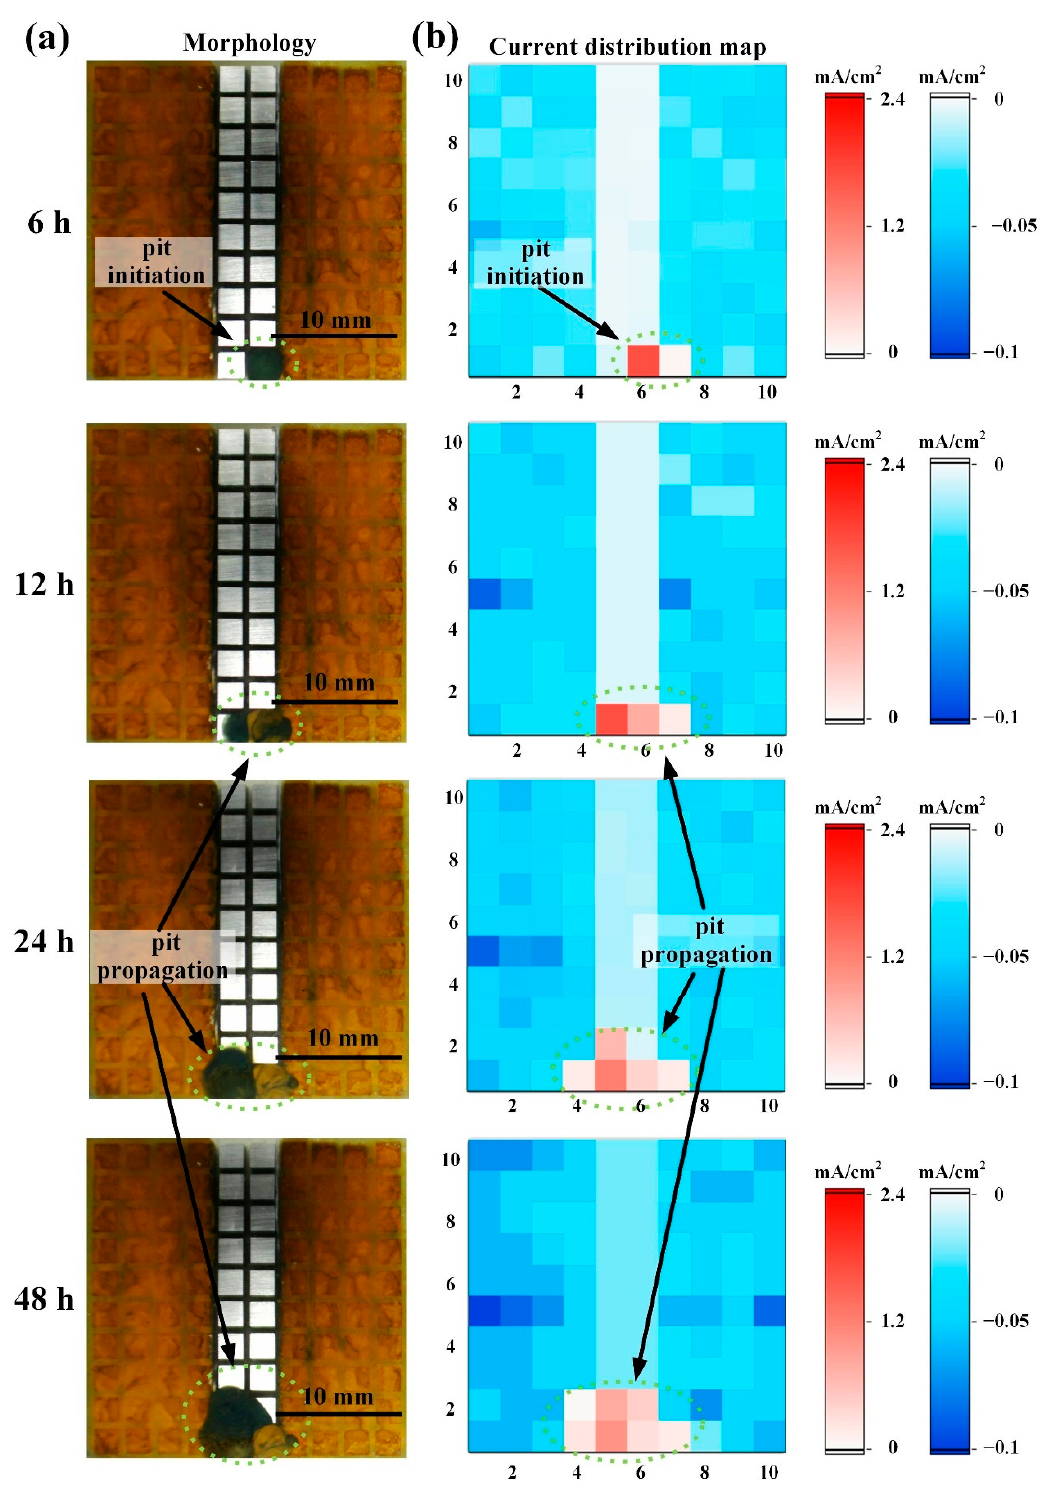
Figure 10. The dynamic change of ( a ) the surface morphology and ( b ) current distributions on WBE after 0.5 mol/L chloride ions were added into the carbonated SCPS. after 0.5 mol/L chloride ions were added into the carbonated